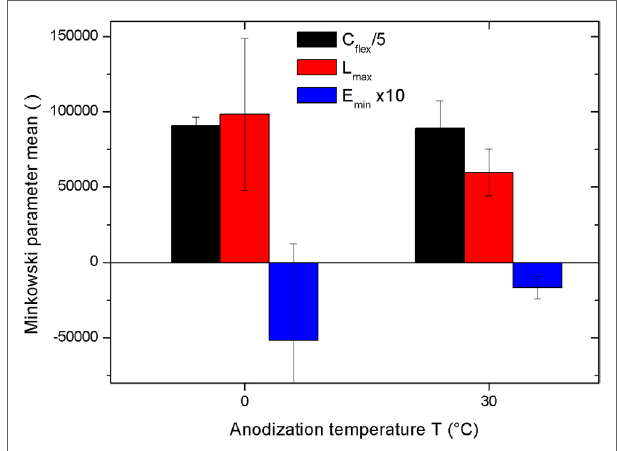
FigUre 4 | Bar plots of the data for all the calculated quantities, 0 versus 30°c set